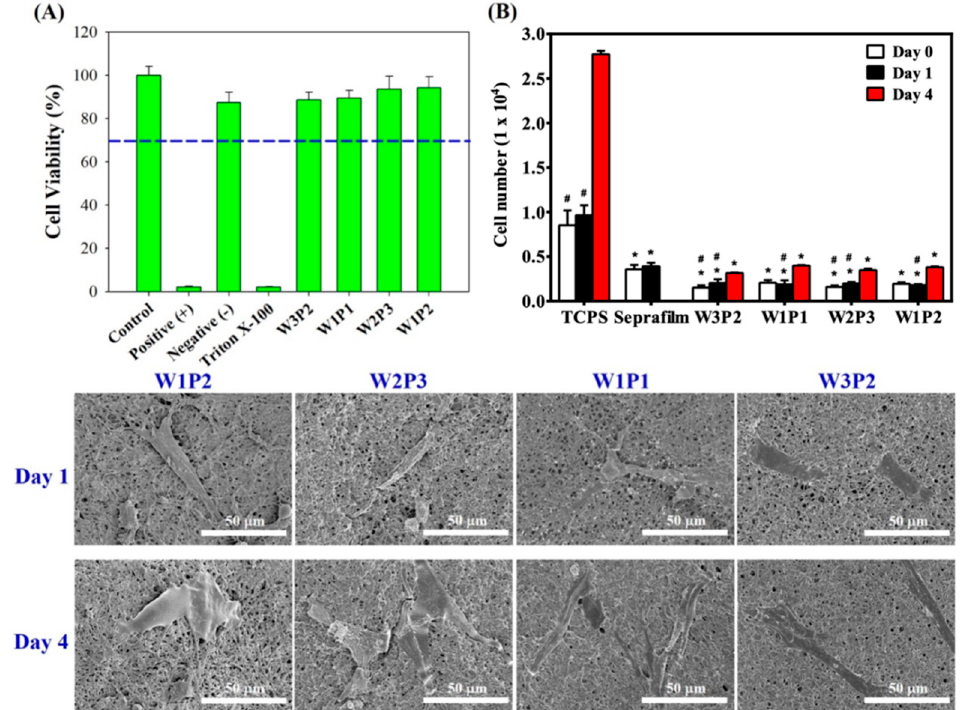
Figure 5. ( A ) The evaluation of cytotoxicity using MTT assays: NFMs with different WPU/PEO volume ratios had similar cell viabilities to the control and negative control, implying that the WPU NFMs are not toxic to human dermal fibroblasts (HDFs). ( B ) The HDF attachment and proliferation assay: HDFs were inoculated on different NFMs and tissue culture polystyrene (TCPS). The cell numbers on day 0, day 1, and day 4 were observed and evaluated using MTT assay. (Bottom rows) The SEM observation of the HDFs attached to NFMs, showing that the HDFs occupied a small area on all NFMs, which correlates with the findings presented in Figure 5B. * p < 0.05 when compared with TCPS, # p < 0.05 when compared with Seprafilm.